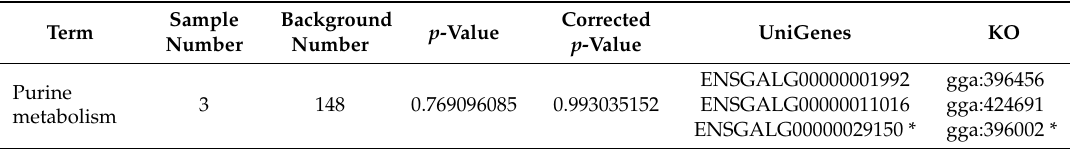
Table 4. Differentially expressed genes in the purine metabolic pathway.